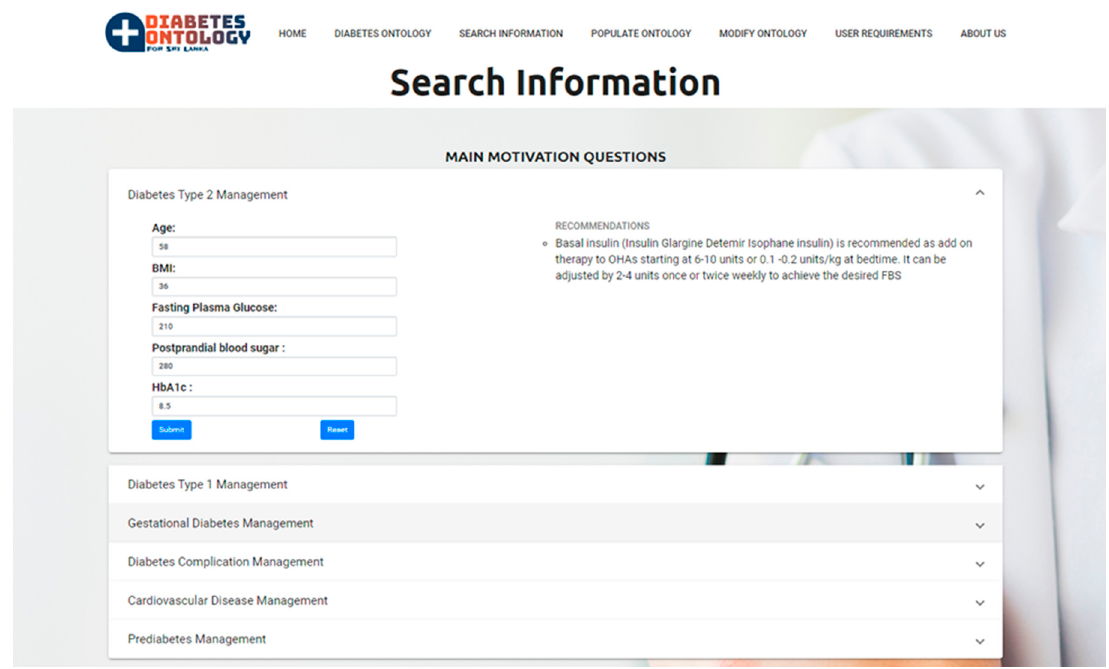
Figure 8. Web-based form related to type 2 diabetes management.